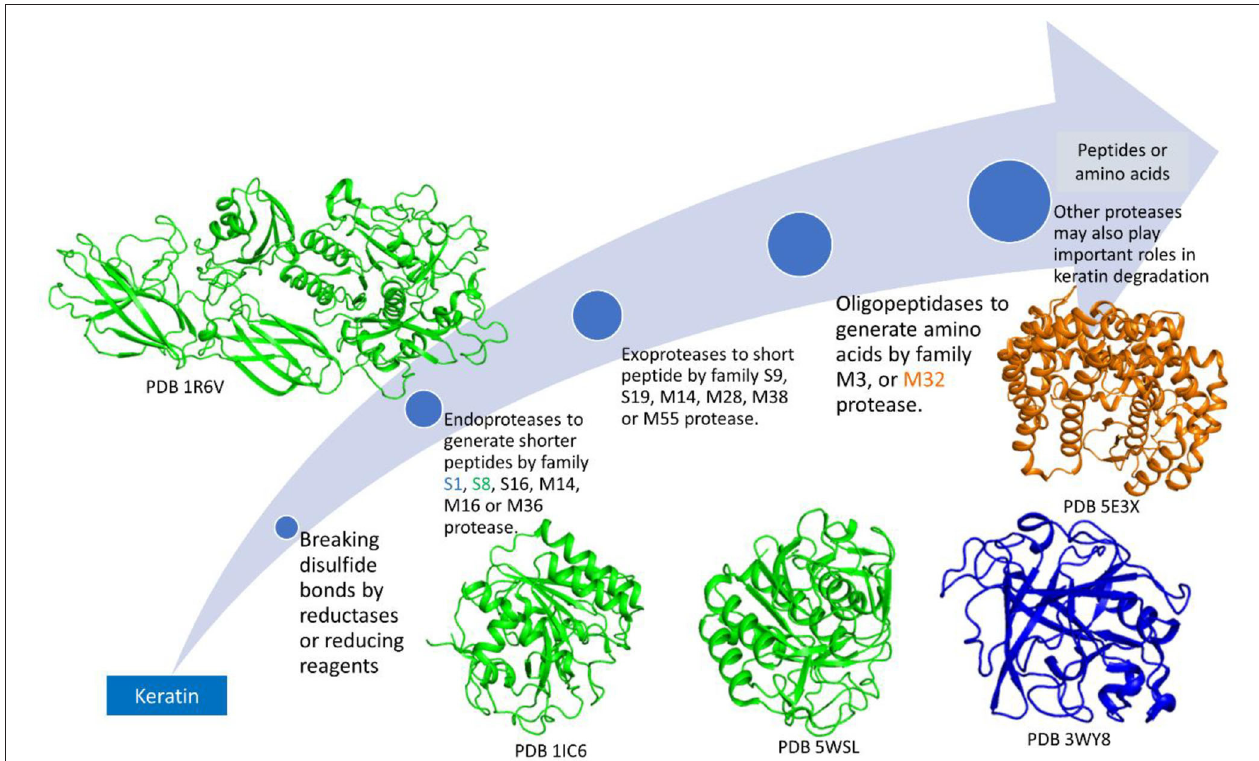
FIGURE 3 | Microbial enzymes involved in keratin degradation. There are at least 14 different protease families identified in microorganisms. These proteases play different roles in keratin degradation. Keratinases among the same family may have different structures. The structures from protein databank (PDB) are shown with the access numbers indicated in the